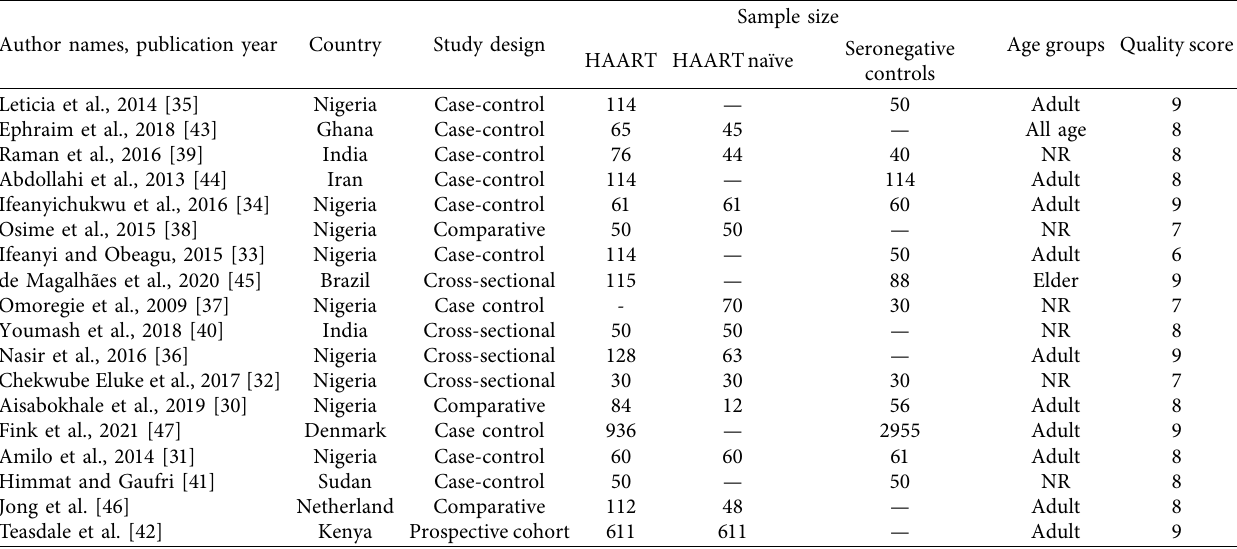
Table 1: Characteristics of the included studies on the coagulation profile of HIV-infected